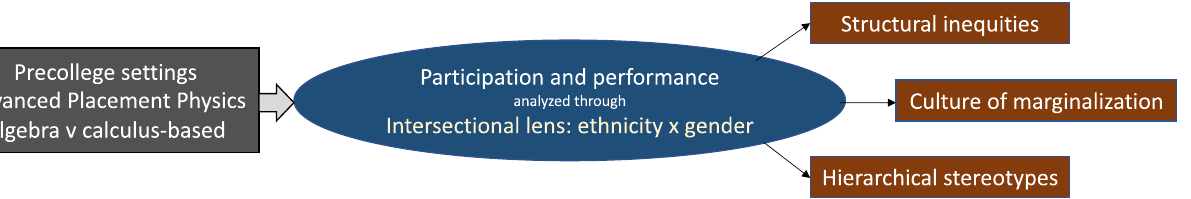
FIG. 1. Theoretical framework for intersectional analysis of Advanced Placement physics access and